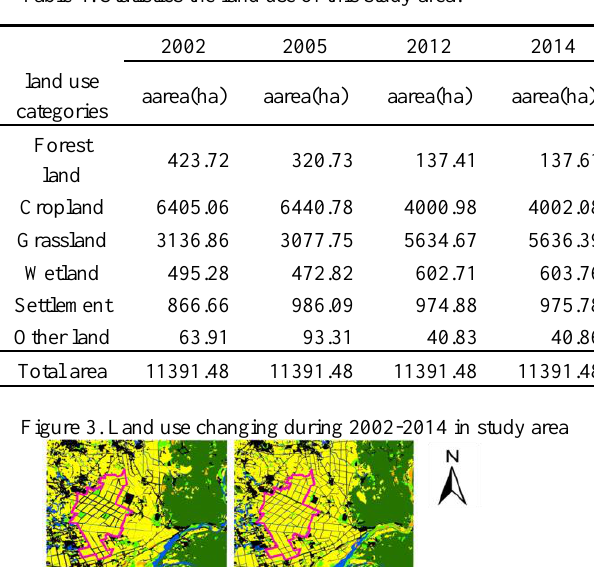
Table 4. Statistics the land use of this study area.